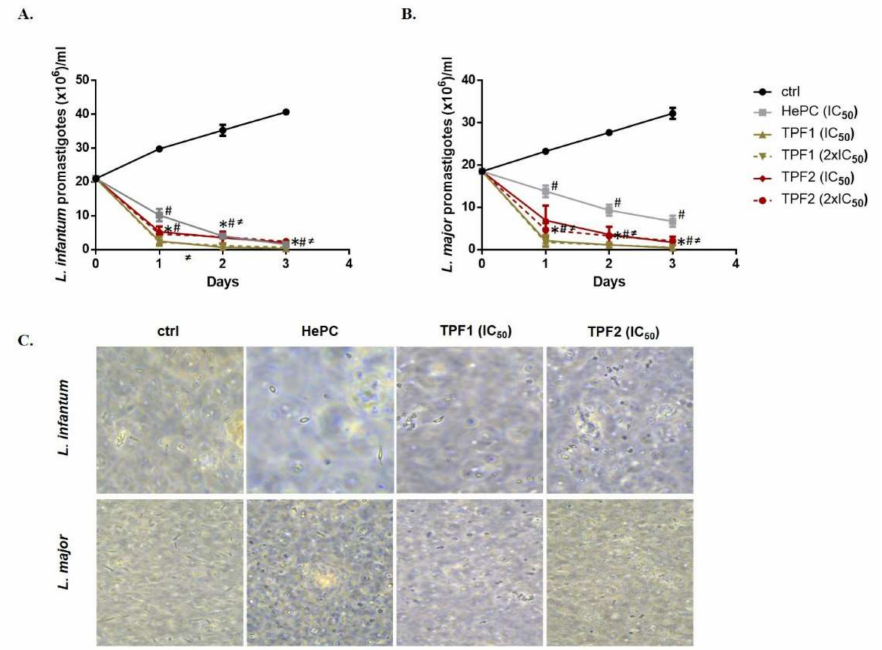
Figure 3. Effect of TPF1 and TPF2 on Leishmania spp. promastigotes growth kinetics.